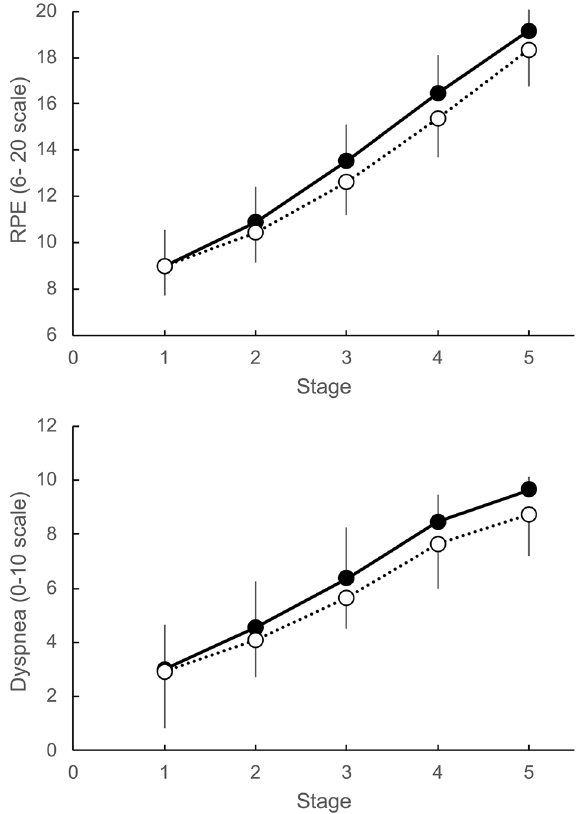
Figure 3. RPE and Dyspnea during incremental running test. Data show RPE [6–20 scale] (upper panel) and dyspnea [1–10 scale] (lower panel). The black circles represent the cloth face masked (CFM) condition. The white circles indicate the unmasked control (CON) condition. There were no significant main effects of the mask factor on either RPE ( P = 0.09, ηp 2 = 0.25) or dyspnea ( P = 0.20, ηp 2 = 0.15). RPE and dyspnea tended to be higher in the FM condition than in the Unmask condition, but the differences were not significant ( P = 0.14, ηp 2 = 0.19, P = 0.06, ηp 2 =